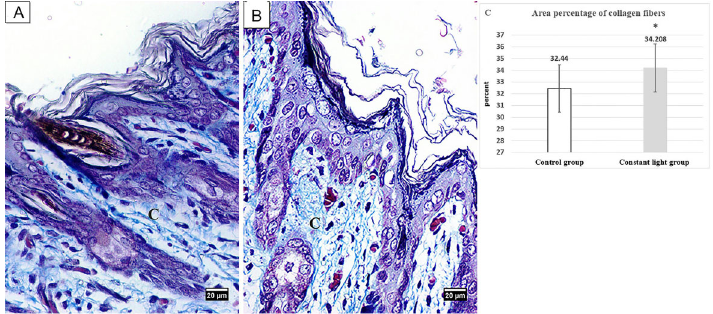
Figure 3. Photomicrographs of Masson ’ s trichrome stained sections of dorsal skin of neonate rabbits ( (cid:1) 400, scale bar 20 m m). A , Control group showing regularly arranged collagen fi bers (C) in the dermis. B , Constant light group showing abundant collagen fi bers (C) in the dermis. C , Means ± SD of area percentage of collagen fi bers/ fi eld. *P o 0.05 vs control group.